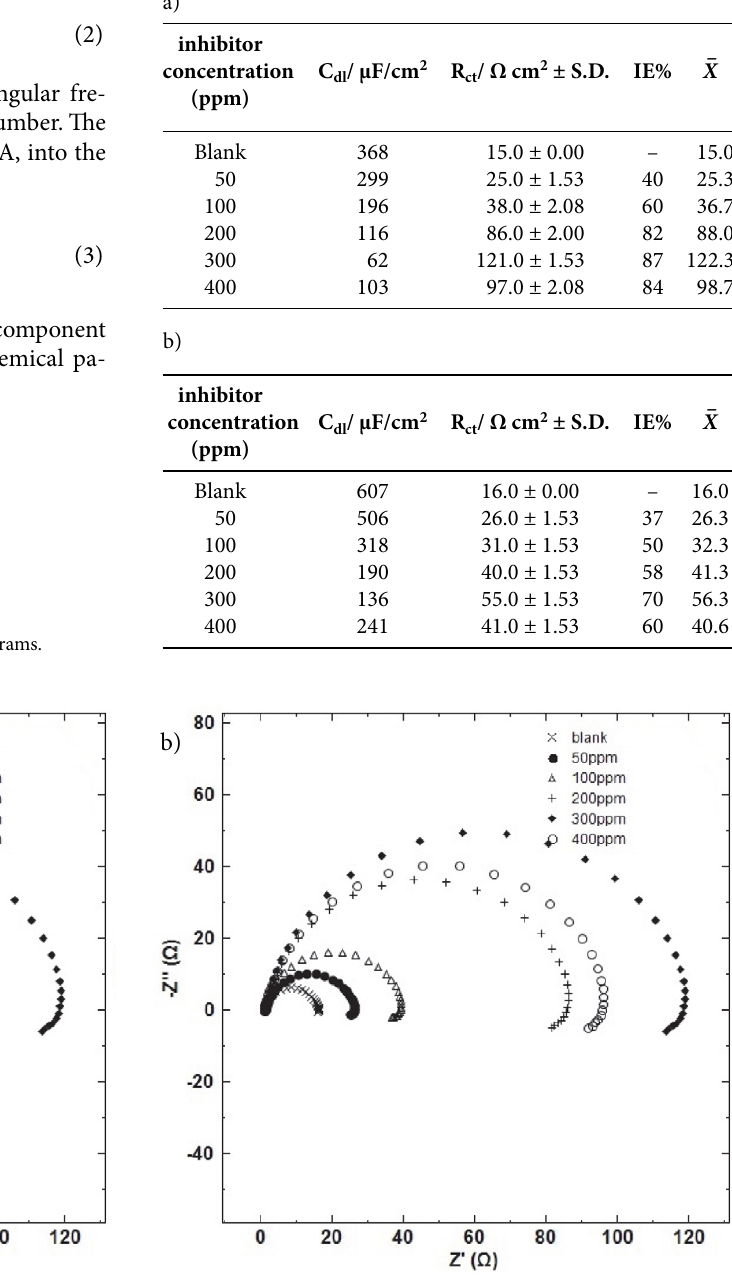
Table 1. Corrosion parameters derived from Nyquist curves for mild steel in a) hydrochloric acid and b) sulfuric acid solution in absence and presence of different concentrations of inhibitor at 25 ± 1 °C. (Results derived from at least two repeats of experiment.) a)